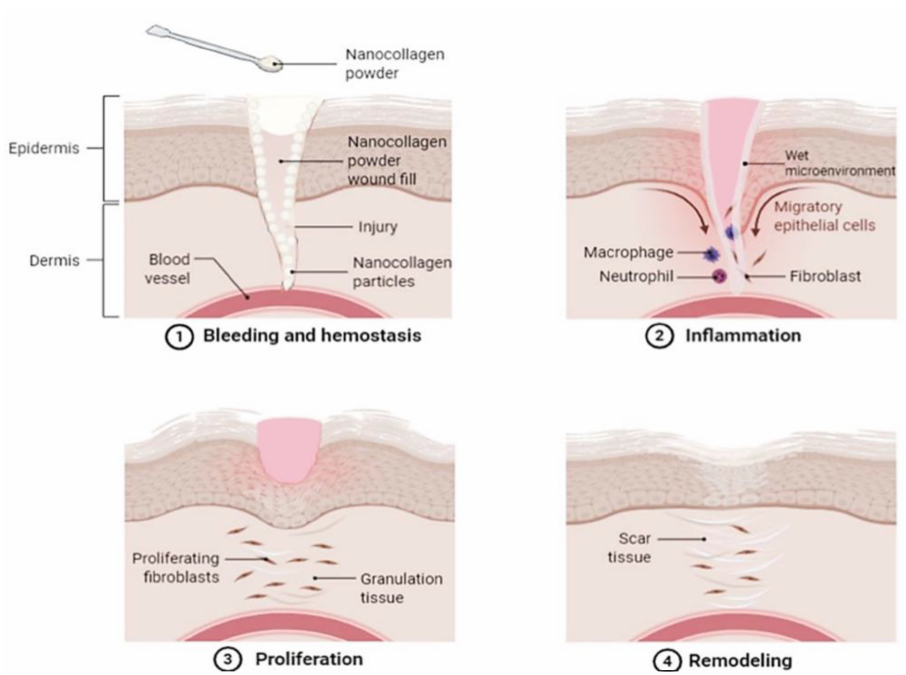
Figure 3. An illustrative image demonstrating a proposed skin wound-healing process with the application of nano collagen powder. The image demonstrates how the powder is applied and fills in the skin wound, where its nano-sized particles better attach to all the crevices of the wound. The nano collagen powder then absorbs exudate secretion and blood, creating a wet microenvironment which acts as a temporary bio-template in the wound. This allows the damaged cells to absorb and benefit from the collagen applied, enhancing healing by encouraging cell migration and proliferation. Created with Biorender.com (Accessed date: 10 February